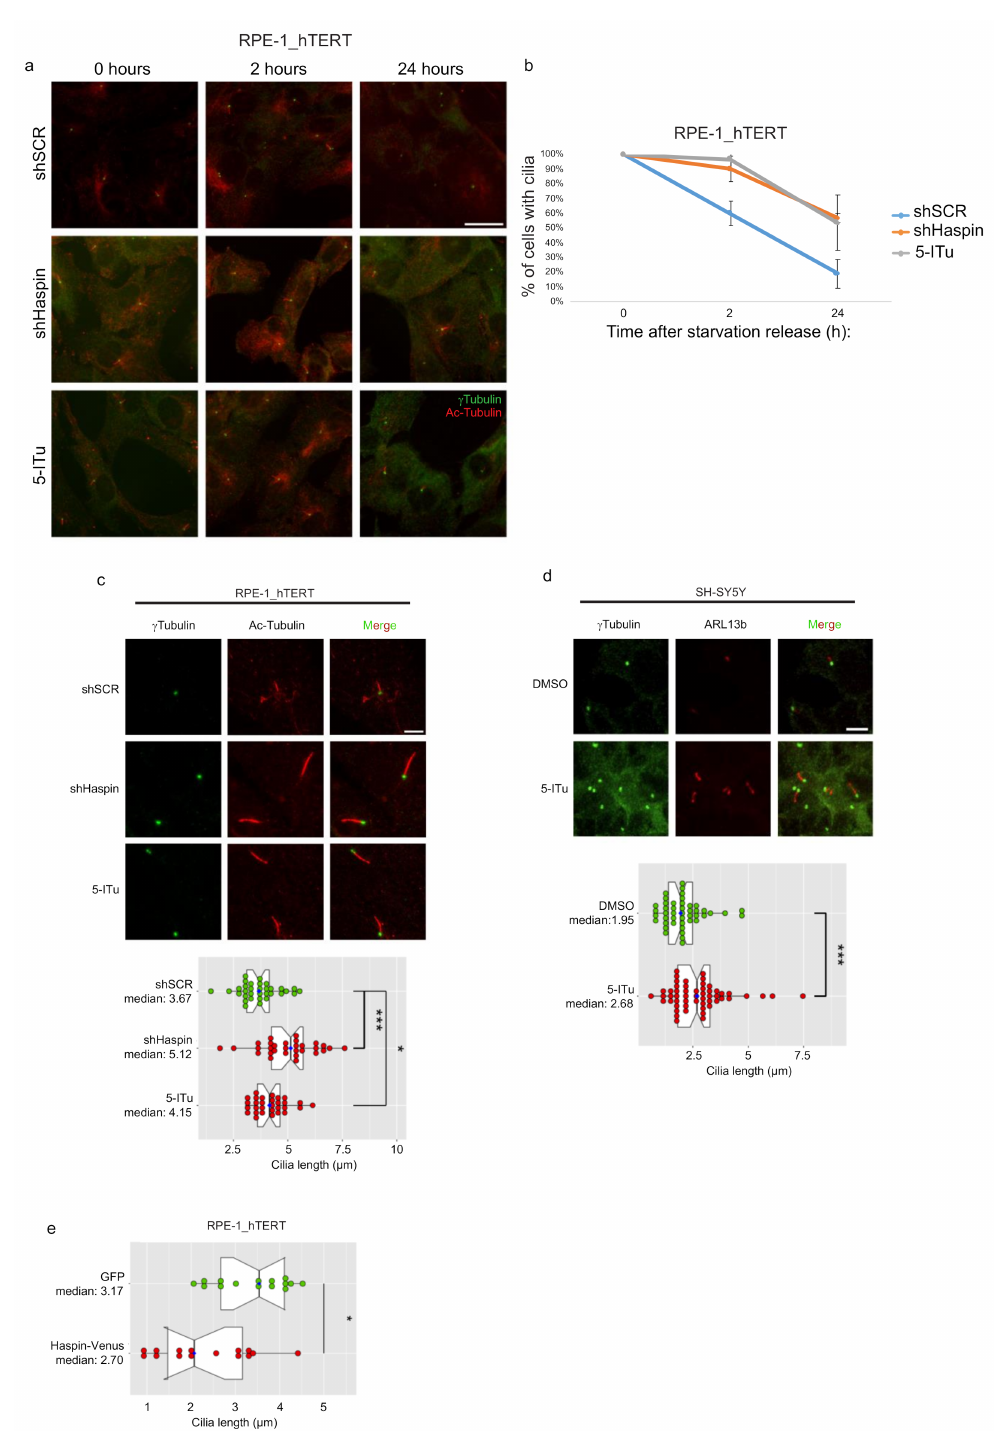
Figure 2. Loss of Haspin leads to longer and more persistent primary cilia. ( a , b ) shSCR and shHaspin were treated as described in Figure 1. For Haspin inhibition, entry into G 0 was achieved by 48 h of serum starvation to induce ciliation. 5-ITu was added after the first 24 h of starvation. Cells were then incubated in the presence of serum to induce cell-cycle entry and cilia resorption. Samples were analyzed by immunofluorescence in G 0 , 2 h, and 24 h after serum readdition. Cells were fixed and processed for immunofluorescence against γ -tubulin and acetylated tubulin; representative images are shown in ( a ), and the percentage of cells with or without cilia is shown in ( b ); error bars represent standard deviation; ( c ) cells were processed as above to measure cilia length at the end of the incubation in serum-free medium. Representative images are shown; ( d ) SH-SY5Y cells were differentiated and processed by immunofluorescence to visualize basal